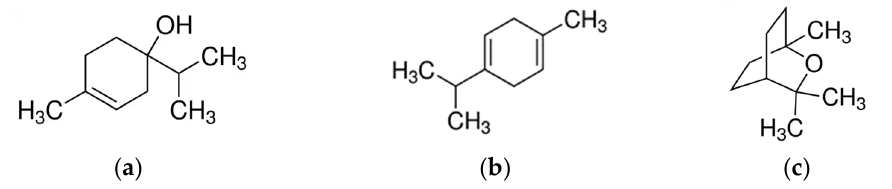
Figure 4. Main components of Melaleuca EOs. ( a ) Terpinen-4-ol; ( b ) γ -Terpinene; ( c ) 1,8-Cineole. Tea tree oil exerts antibacterial action against E. coli and S. aureus , destabilizing po- tassium ion gradients, inhibiting respiration, and promoting membrane leakiness, and so far, development of multistep antibiotic resistance in the presence of tea tree oil or ter- pinen-4-ol has not been observed to have any signi fi cant impact [112].